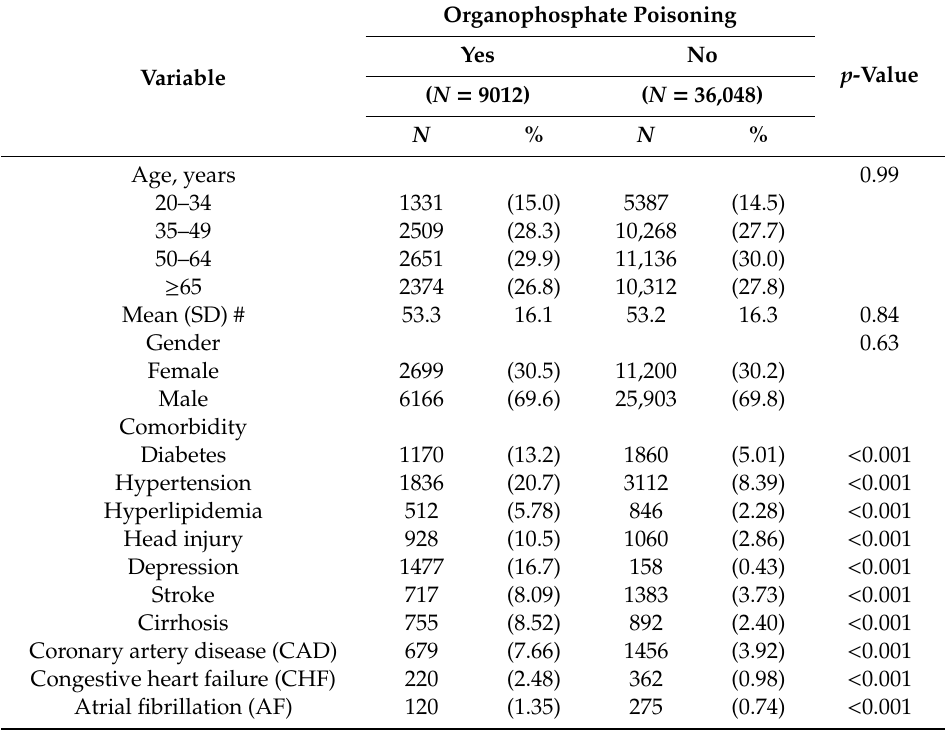
Table 1. Characteristics of patients with and without organophosphate poisoning.